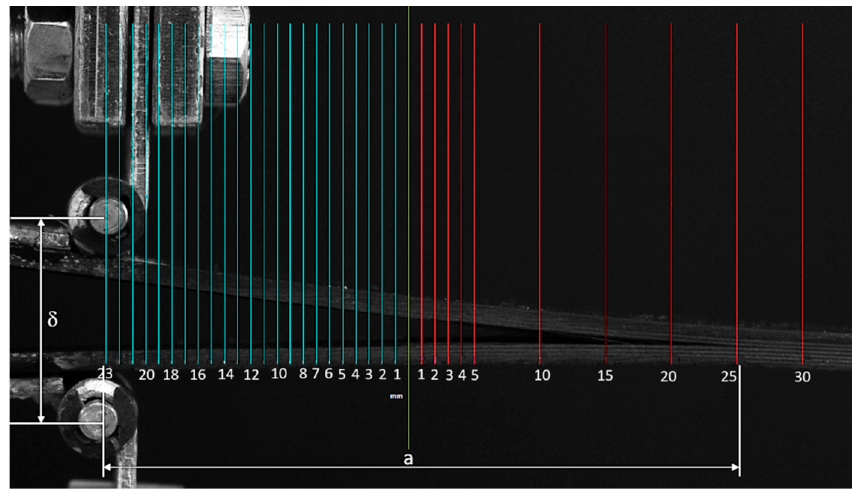
Figure 3. Digital grid for crack growth evaluation.